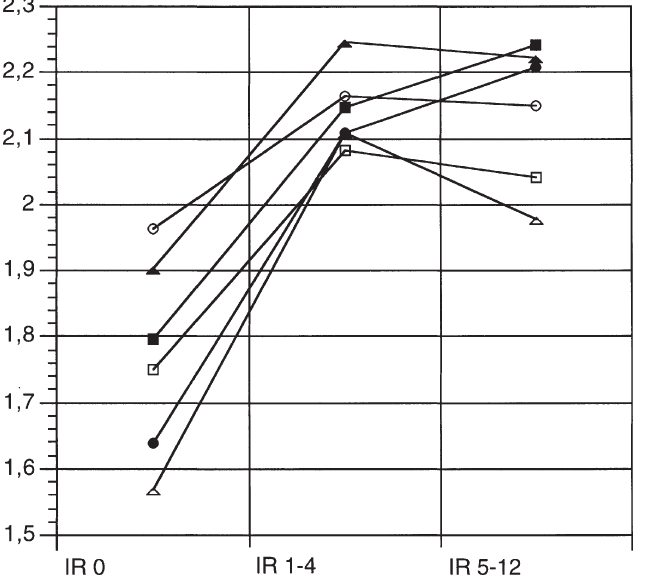
Fig. 1. Standard deviation of the shape factor (S.D. FormFak) in breast cancers with different p53 expression in correlation to the tumour size and the lymph node status. IR 0 . . . p53 negative tumours; IR 1–4 . . . weakly p53 positive tumours; IR 5–12 . . . strongly p53 positive tumours. 1 pT1; 2 pT2–4; ! pN0; " pN1–2; P pT1pN0; Q pT2–4pN1–2.